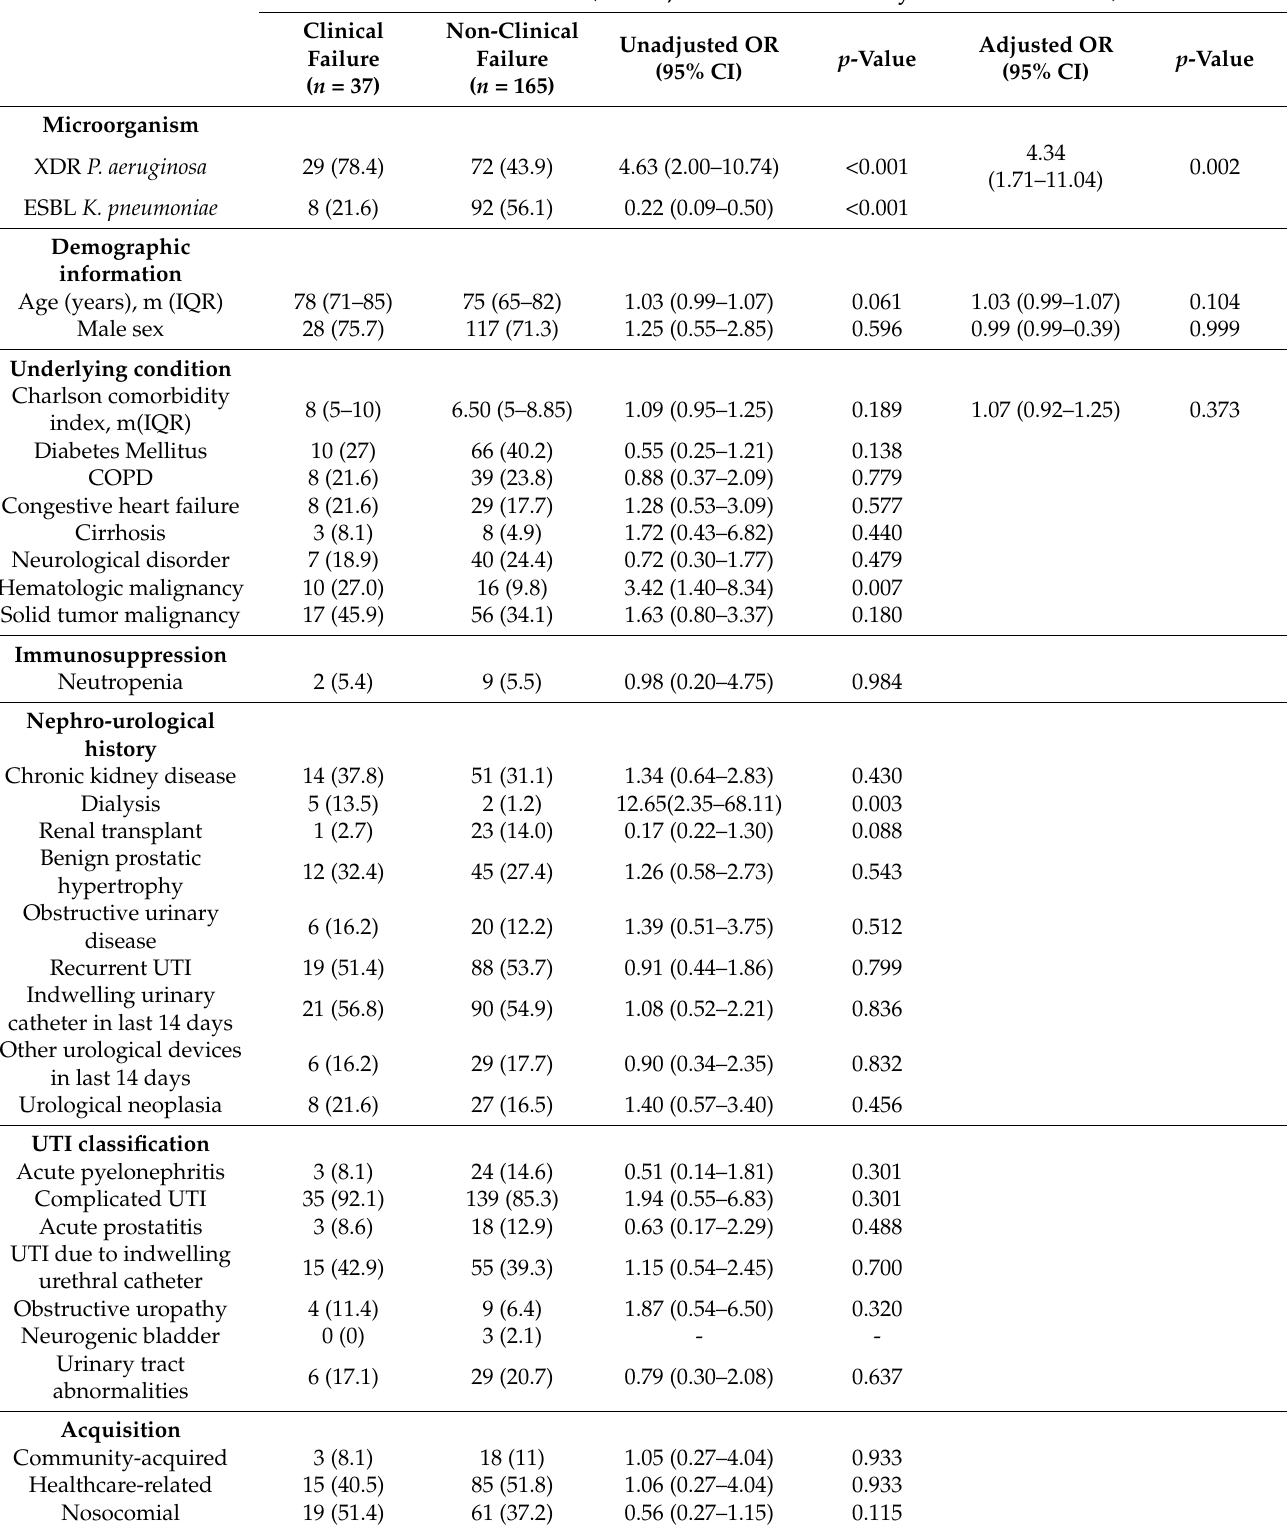
Table 2. Univariate and multivariate analysis of parameters predicting clinical failure at day 7 of